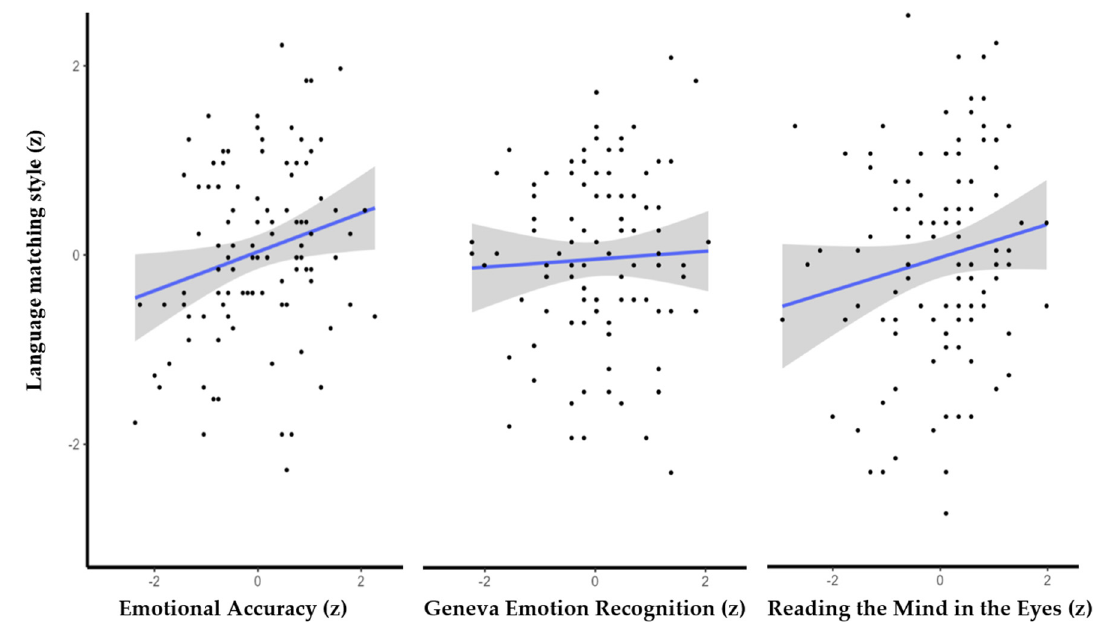
Figure 1. The simple correlation between language style matching and accurate emotion recognition on the EAT ( left ) and the GERT ( middle ), and the RMET ( right ). Note. Grey denotes 95% confidence intervals.